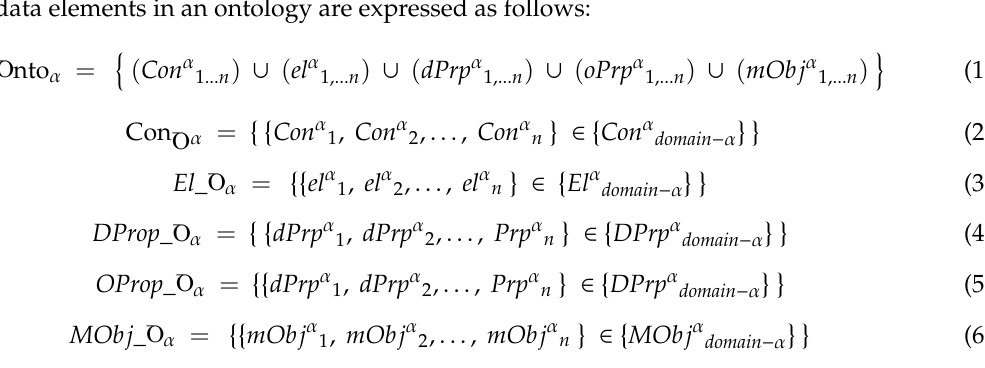
Figure 8. Ontology graphs data descriptions.